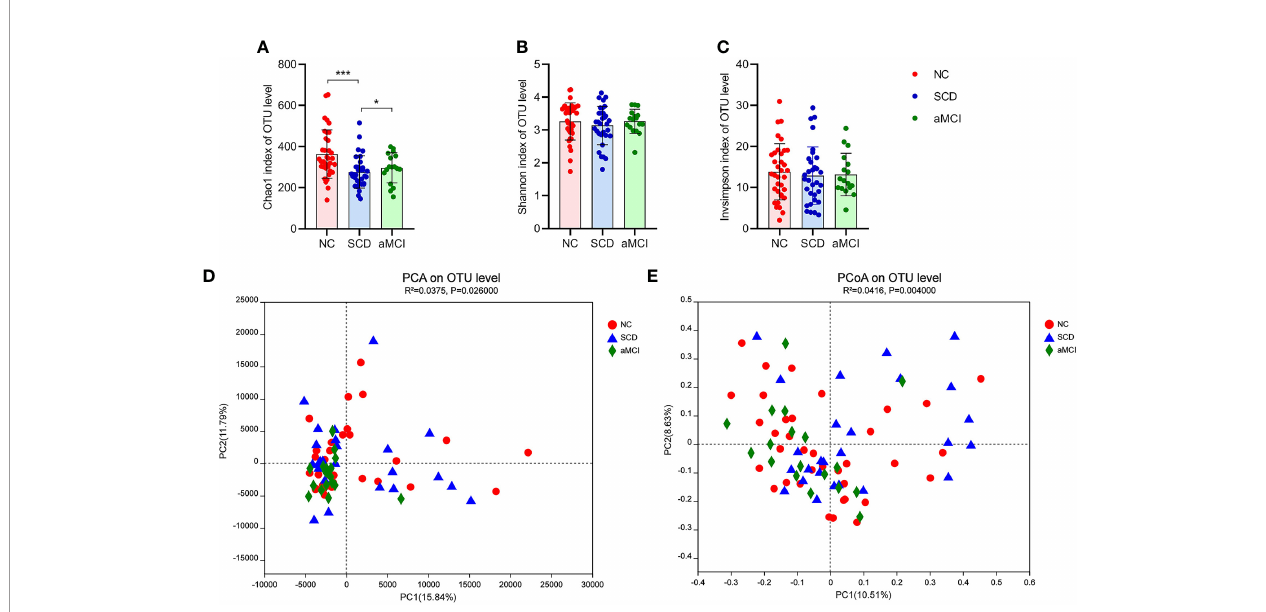
FIGURE 1 | (A – E) Alpha and Beta diversity analysis in intestinal fl ora between different cognitive groups. (A – C) The X axis and the Y axis represent the groups and alpha diversity indices respectively. And the error bar means the standard deviation. Wilcoxon rank-sum test showed that the differences in chao1 index among the three groups were signi fi cant at the OTU level (*P-value < 0.05, ***P-value < 0.005, Wilcoxon rank sum test), which meant that the species richness of intestinal fl ora in the SCD group was lower than in the other two groups. Shannon and inverse Simpson indices were not different signi fi cantly among three groups, which indicated that the species evenness of intestinal fl ora was not obvious different between three groups (P-value > 0.05, Wilcoxon rank sum test). (D, E) The X axis and the Y axis represent two selected principal coordinate axes, and the percentage represent the interpretation value of the principal coordinate axis for the difference in sample composition. Each point represents a sample, whereas red circle, blue triangle, and green square represent the NC, SCD, and aMCI groups respectively. The closer the two sample points are, the more similar the species composition of the two samples is. Beta-diversity analysis results showed that the species composition in three groups was obvious different from each other. PCA and PCoA analysis both indicated that ANOSIM test results had a signi fi cant P value (PCA analysis: R 2 = 0.0375, P = 0.026; PCoA analysis: R 2 = 0.0416, P = 0.004).